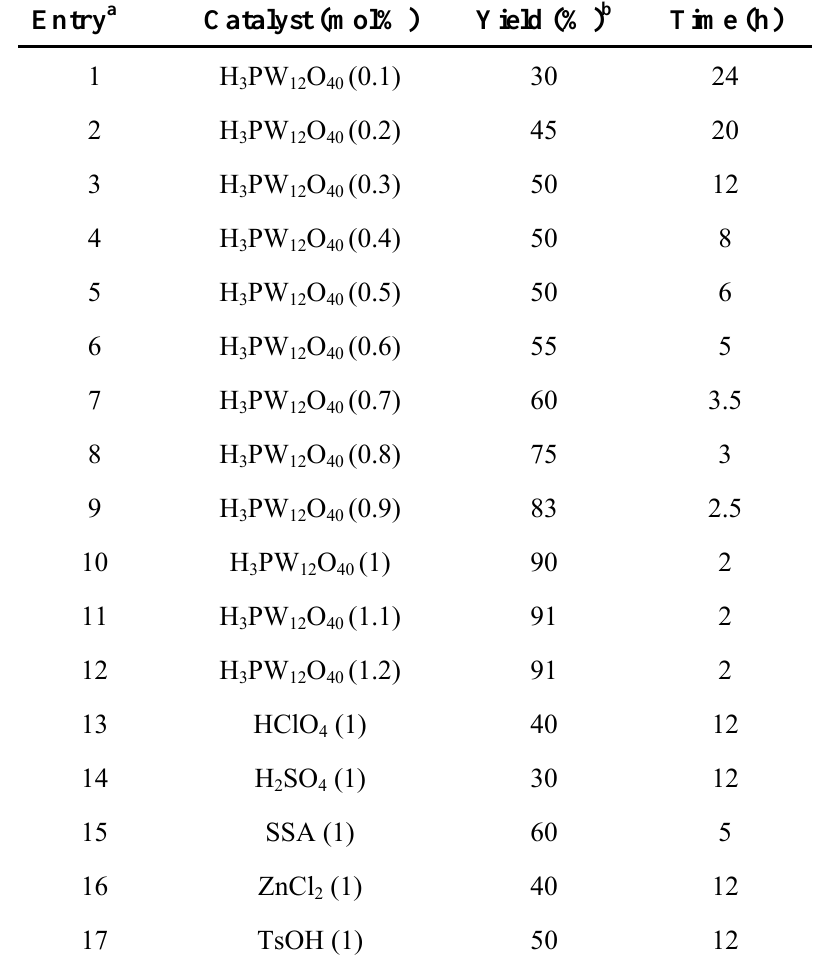
Table 1. Effect of amounts of H reaction of 2-aminobenzophenone ( 1 ), and ethyl acetoacetate ( 2